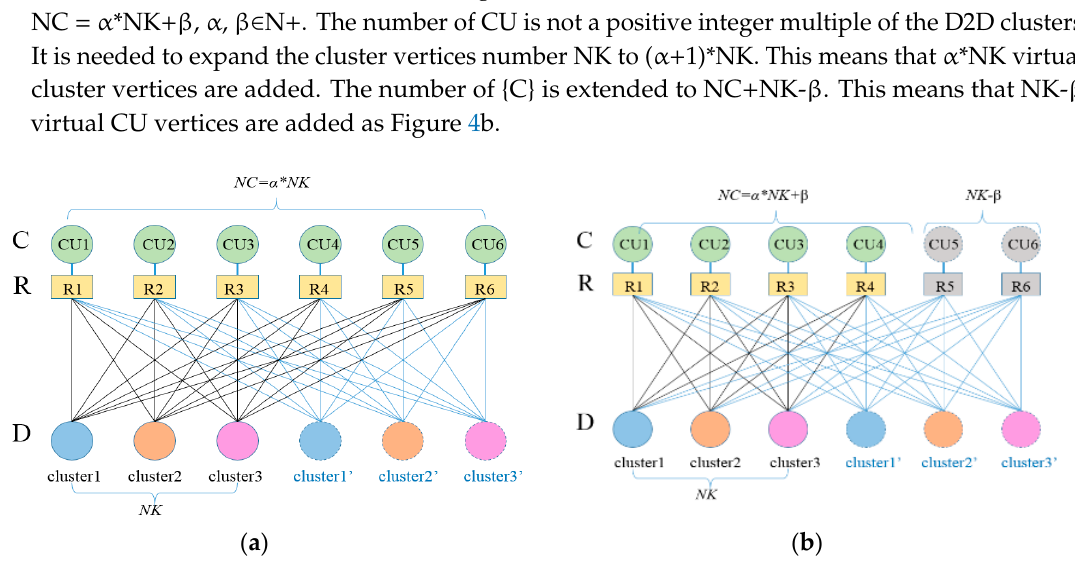
Figure 4. Bipartite transformation of the original matrix: ( a ) NC= α *NK; ( b ) NC= α *NK+ β .